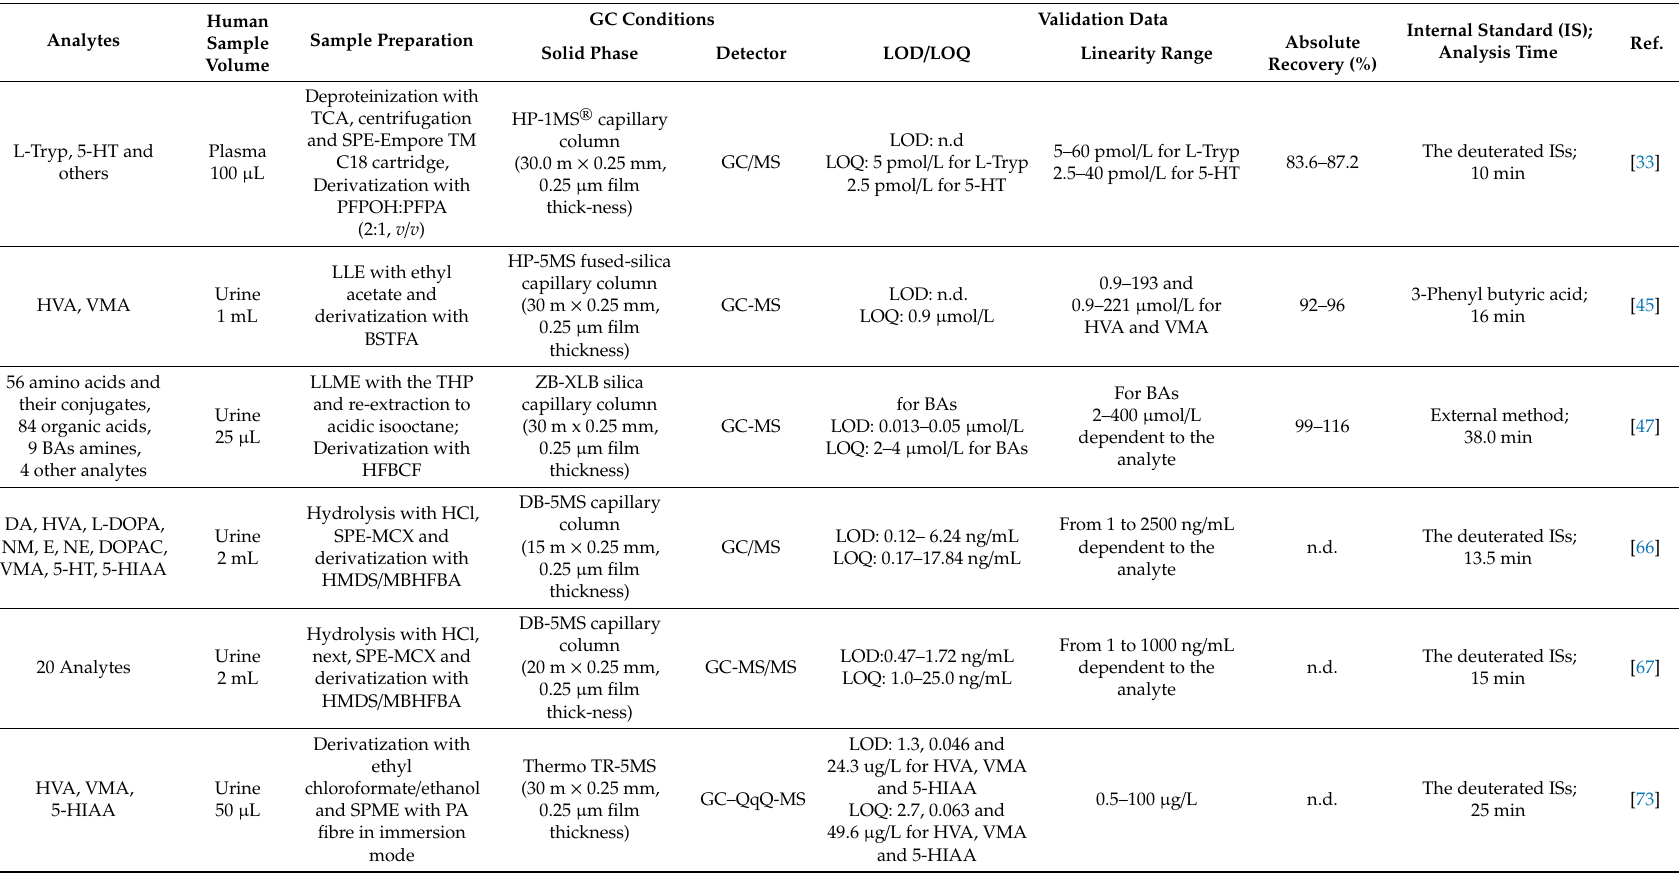
Table 3. GC methods for the separation of selected BAs in human specimens published since